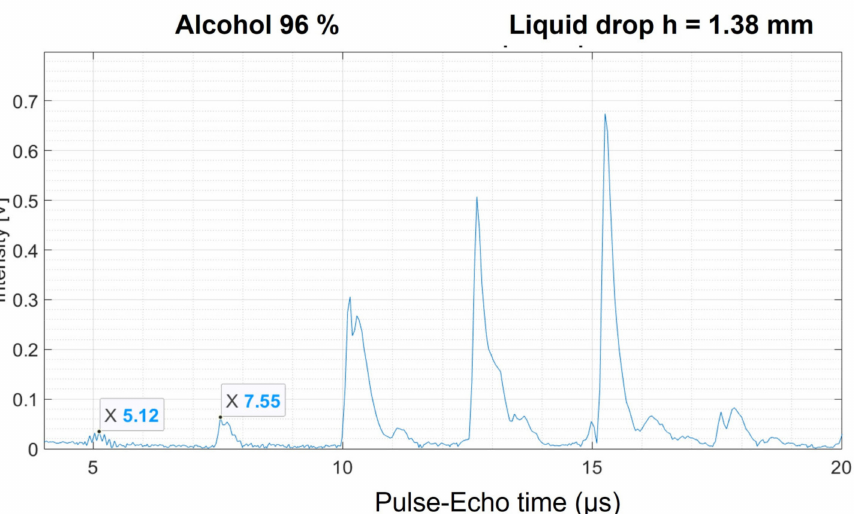
Figure 10. Room temperature A-scan of a drop of ethanol with 96% purity. The series of peaks with increasing intensity is the result of resonances created by the metallic exterior of the